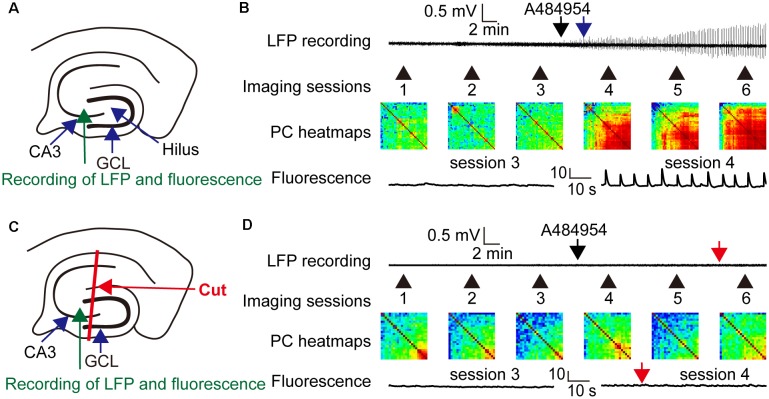
Drug effects on LFPs and fluorescence signals in coupled and uncoupled entorhinal–hippocampal acute slices. (A) Schematic representation of LFP and fluorescence recording sites in the CA3 area (green arrow). (B) A representative LFP trace has been shown indicating the time point of drug application (black arrow) and the onset of oscillation (blue arrow). In the same experiment, the fluorescence changes were acquired six times. Every session took place as indicated with the numbered black arrows. The intersession interval was 10 min. The heat map indicates the gradual synchronization of the fluorescence transients between different pairs of ROIs. In the heat map of session 6, most pairs correlated in their activity with a high PC (>0.8, yellow–red). Representative fluorescence traces have been shown for sessions 3 and 4 below the heat map (ΔF/F0: vertical scale bar). (C) Schematic representation of LFP (green arrow) and fluorescence recording (blue arrow) sites in the CA3 area. The slice was lesioned along str. oriens-sl-m of the CA1 region, through the hilus up to the outwing of the DG region. This lesion uncouples the CA3 region from entorhinal inputs. (D) The outline of the panel follows the outline presented in (B). The red arrows indicate the absence of any LFP oscillation or fluorescence signals in the entorhinal-hippocampal uncoupled slice. In addition, the PC heat map did not indicate an enhancement of cross-correlation coefficients. Thus, the experiments demonstrated a dependency of drug induced oscillation or synchronization of neurons by the specific entorhinal fiber bundle that terminates in the region of CA3–CA2 in the sl-m.